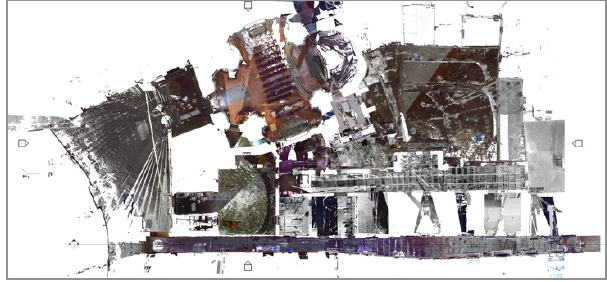
Figure 3. Palazzo Penne, plan view. Pointcloud in Autodesk